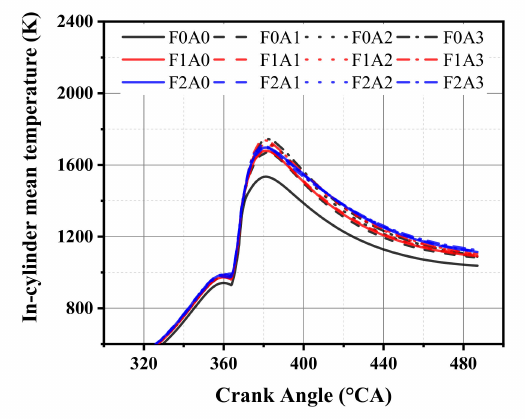
Figure 5. The comparison of temperature in the cylinder of different grid